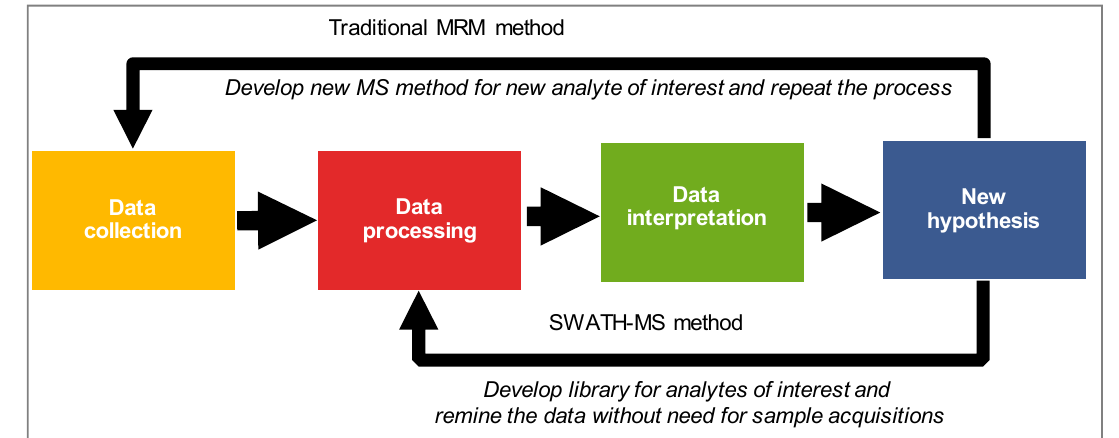
Figure 2. A graphical illustration of the advantage of SWATH–MS over the traditional MRM-based quantification method. MRM, multiple reaction monitoring; SWATH–MS, sequential windowed analysis of all the theoretical mass spectra.